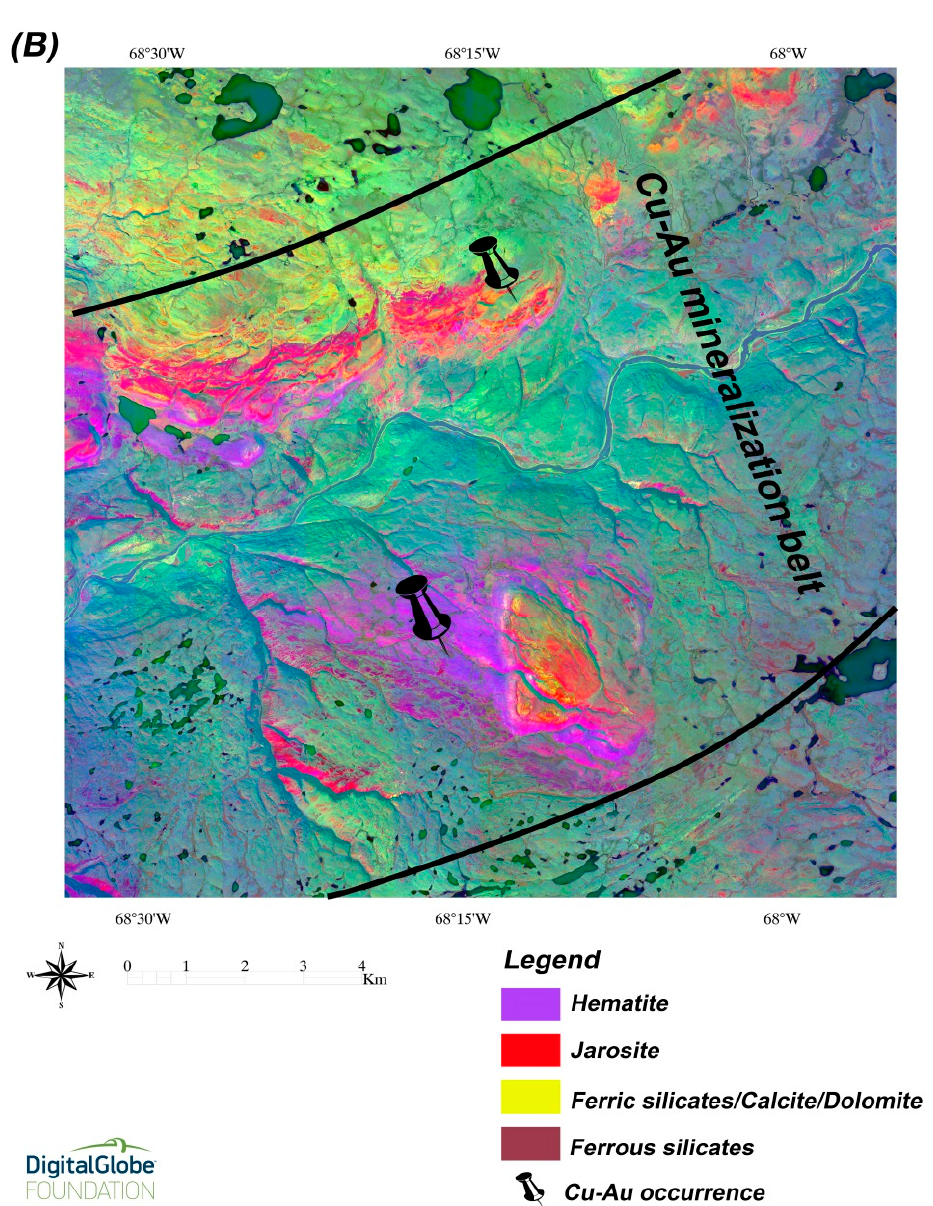
Figure 11. ( A ) The n-D classes (end-member spectra) extracted for the WV-3 selected spatial subset covering the southern part of the Cu-Au mineralization belt. WV-3 band center positions are shown. ( B ) LSU mineral map produced from fraction images for the selected spatial subset covering the southern part of the Cu-Au mineralization belt (WV-3 image, courtesy of the DigitalGlobe Foundation (www.digitalglobefoundation.org)).